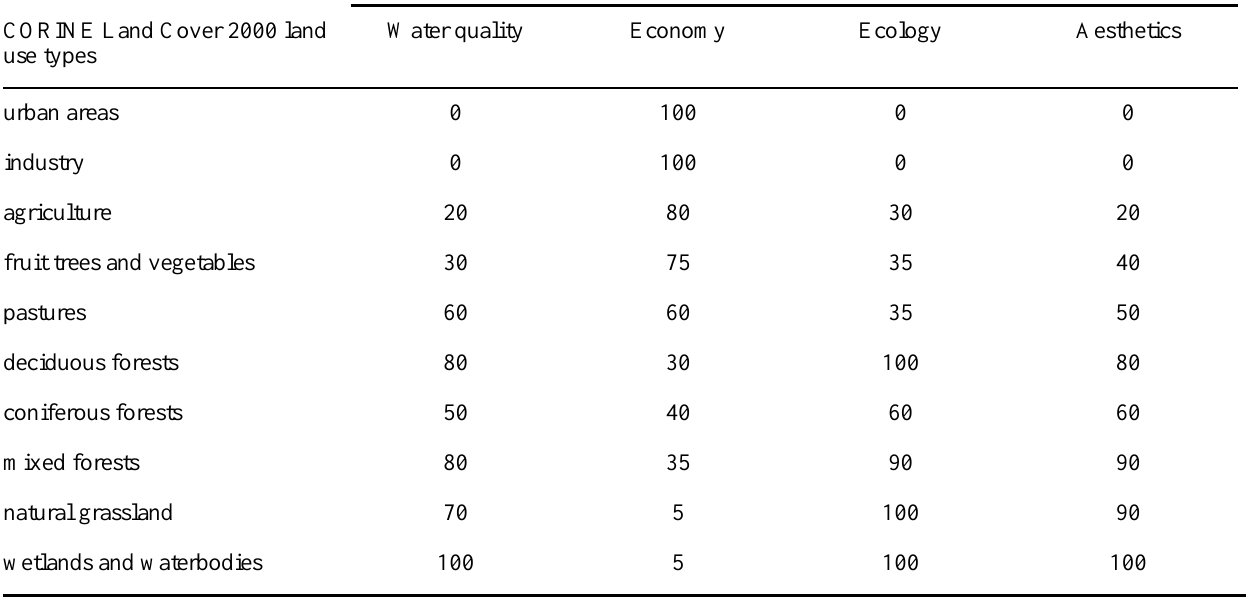
Table 3 . Exemplary evaluation table for the Euro Region Neisse. Values of the land use types for the land use